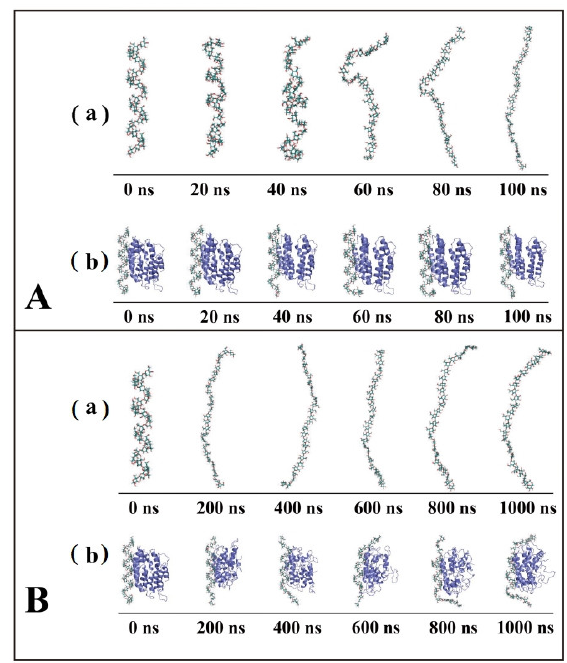
Figure 1. Conformational changes and snapshots of amylose molecule ( a ) and amylose–zein com- plexes ( b ) in water at different time intervals between 100 ns ( A ) and 1000 ns ( B ).